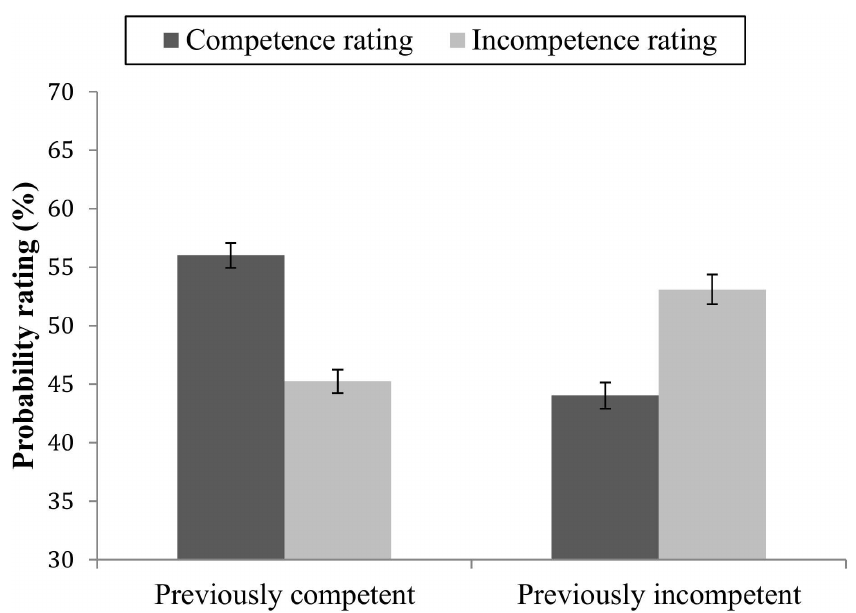
Fig 8. Mean probability ratings of future competent and future incompetent behaviors. Ratings of targets with previously mainly competentor mainly incompetent behavior. Error bars represent standard